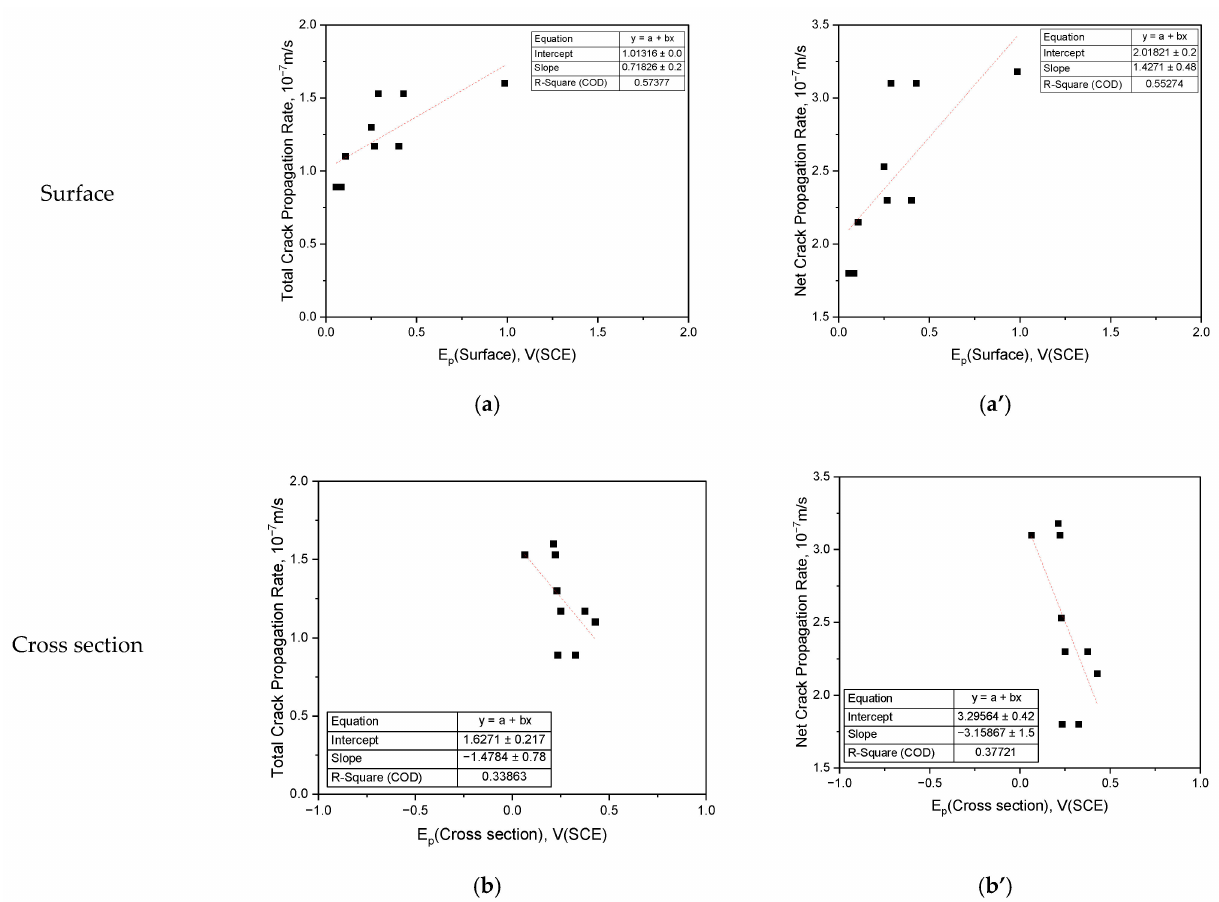
Figure 14. Relationship between the crack propagation rate and pitting potential: ( a , b ) total crack propagation, ( a’ , b’ ) net crack propagation